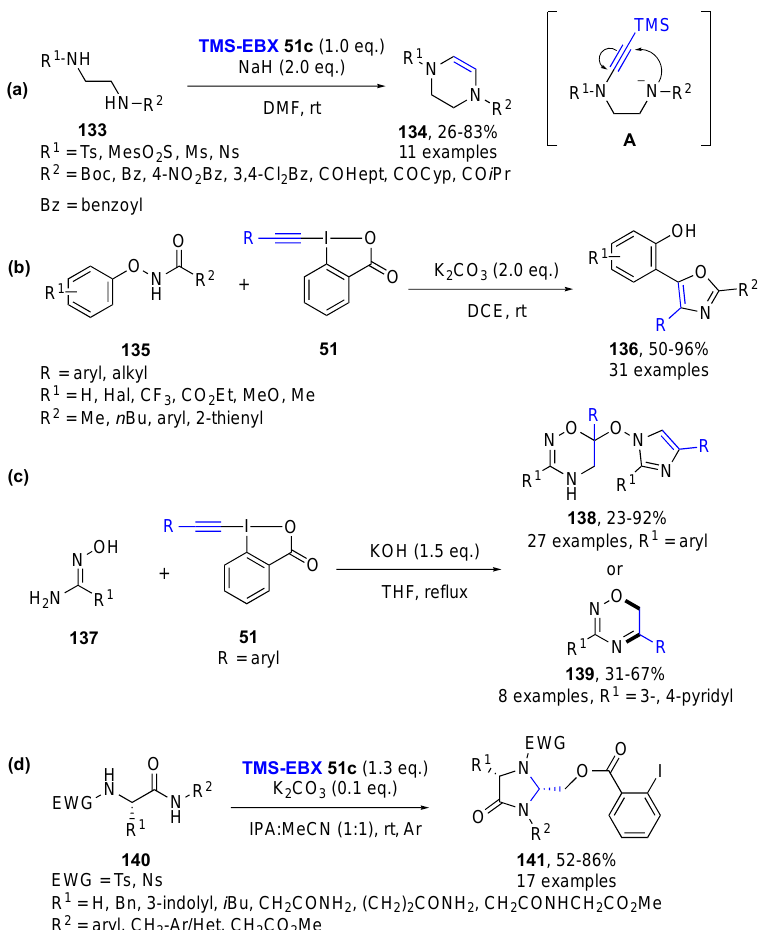
Scheme 28. Transition metal-free EBXs 51 -mediated synthesis of heterocycles. See explanation of reactions ( a – d ) in the text.